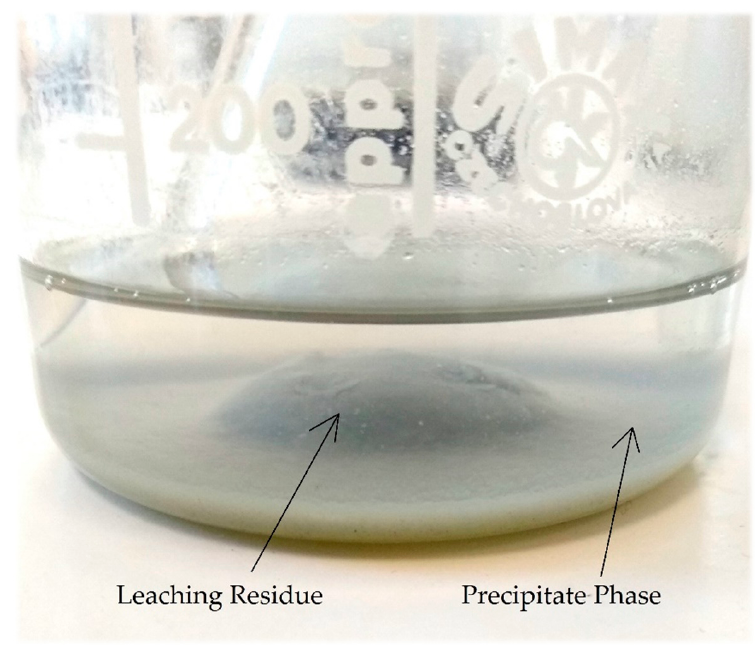
Figure 19. Leaching residue and precipitated phase after dry digestion followed by neutral leaching.